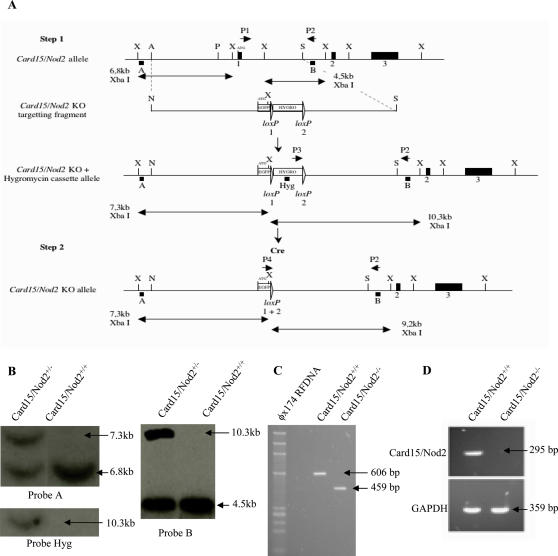
Targeting disruption of the murine Nod2 gene by homologous recombination.(A) Generation of the Card15/Nod2 KO allele: targeting strategy. The restriction maps of the Card15/Nod2+allele (5′ portion), the Card15/Nod2 KO targeting fragment, and the modified Card15/Nod2 allele after homologous recombination and Cre-mediated recombination of an Hygromycin selection cassette are shown. Exons 1, 2, and 3 (black boxes) and restriction sites used for cloning and screening (X) XbaI, (A) AgeI, (P) PmlI, (S) SalI, (N) NotI are indicated. The Card15/Nod2 KO targeting fragment comprises the EGFP gene (Clontech) in frame with Card15/Nod2 ATG and the floxed PGKHygromycin (Clontech) selection cassette, introduced between the AgeI site downstream of Card15/Nod2 exon 1 and the SalI site upstream of exon 1 in the Card15/Nod2 orientation. All loxP sites are represented by open triangles. Recombination of loxP1 and loxP2 results in the loxP1+2 site. In the first step of the strategy, the Card15/Nod2 locus was targeted with the Card15/Nod2 KO targeting fragment. In the second step, the PGKHygromycin selection cassette was removed by Cre recombinase. The double-headed arrows indicate the DNA fragments resulting from digestions with different enzymes expected to hybridize with probes A, B or Hyg. Also depicted are combinations of PCR primers P1-4 that detect the different Card15/Nod2 alleles. (B) Southern blot analysis of restricted DNA resulting from digestion with XbaI.Hybridation with Probe A and B show complete integration of the targetting fragment after homologous recombination. Probe Hyg show the differents integrations of targetting fragments after homologous recombination. (C) Genotyping of Nod2-deficient mice by PCR. Genomic DNA from mice was amplified by PCR to detect the disrupted sequence (PCR product of 459 bp). (D) Expression of Nod2 mRNA in spleen. RT-PCR was performed on purified mRNA from the spleen of WT and KO mice. As expected, no signal was observed in KO mice. GAPDH expression was used as positive control of expression.